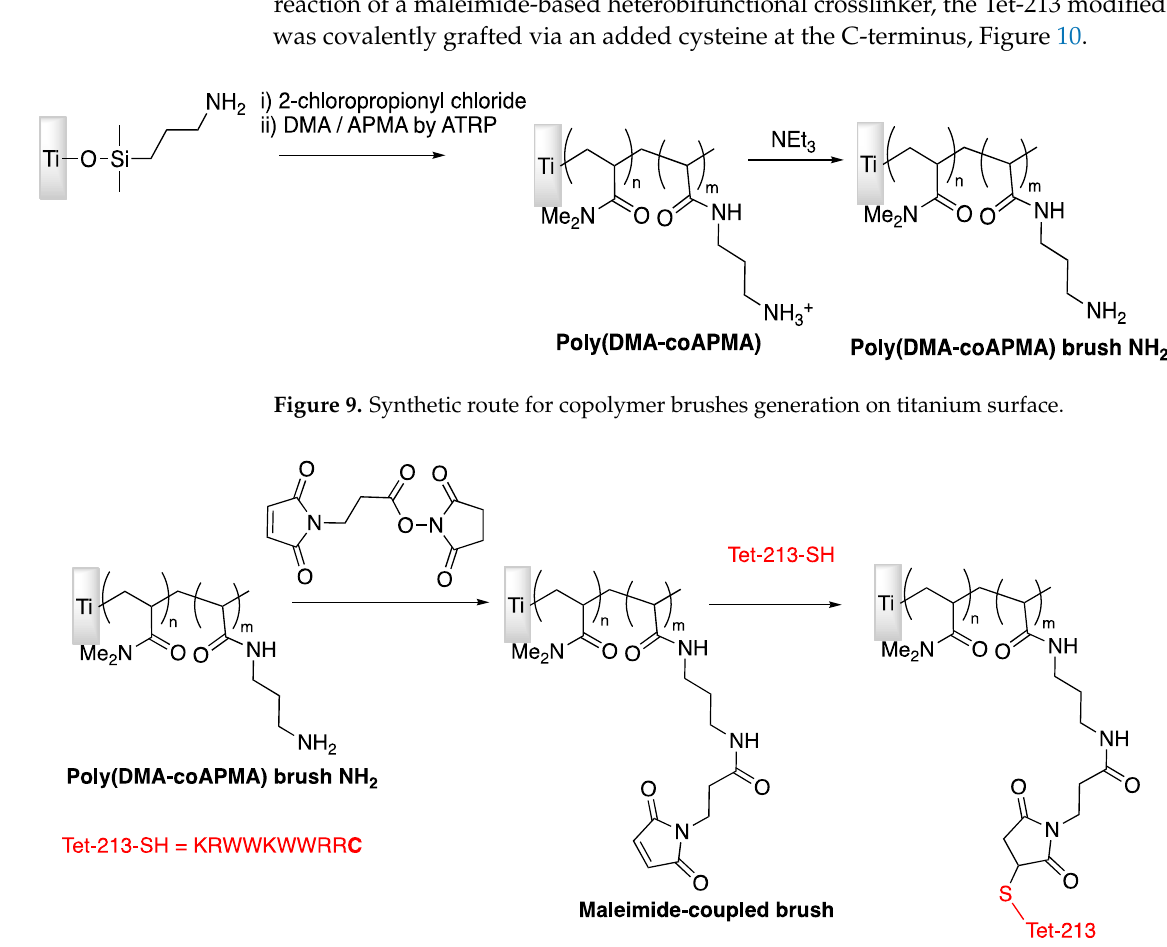
Figure 10 . Different steps of functionalization to study the influence of brush properties of poly- mers on AMPs activity. Adapted with permission from [74]. Copyright 2011 American Chemical Society.